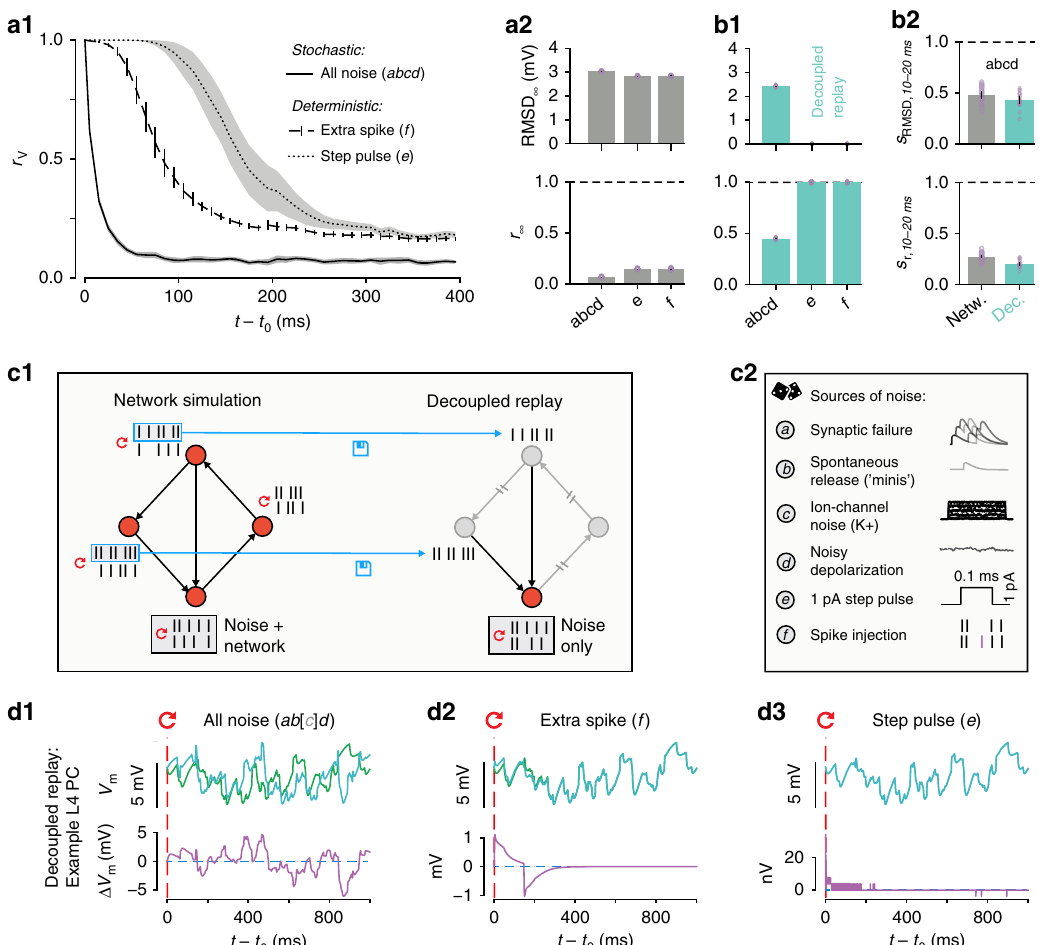
Fig. 3 Noise ampli fi ed by chaos determines divergence. a1 Time-course of correlation r V after resuming at t 0 from identical conditions with different forms of perturbation. Full cellular noise as before, solid line ( abcd ); no cellular noise, but perturbing with a single extra spike in one neuron, dashed line ( f ); a miniscule step-pulse perturbation in all neurons, dotted line ( e ). ( abcd : 40 saved base states; e , f : 20 saved base states; mean ± 95% con fi dence interval). a2 Steady-state root-mean square deviation RMSD ∞ and correlation r ∞ for stochastic ( abcd ) and deterministic simulations ( e , f ) as de fi ned in a1 (mean ± 95% con fi dence interval in black; individual base states in purple dots). b1 As in a2 , but for decoupled, replayed simulations. (20 saved base states). b2 Similarity s RMSD and s r at 10 – 20 ms with all noise sources enabled, for network and decoupled simulations (mean± 95% con fi dence interval). c1 Decoupled replay paradigm. Presynaptic spike trains from a network simulation are saved and then replayed to the synapses of each neuron in a decoupled simulation, thereby removing variability due to feedback network dynamics. c2 Overview of sources of noise and perturbations. d Decoupled replay simulations (see c1 ) for a representative L4 PC neuron, with somatic membrane potential differences between the two trials only due to cellular noise sources ( ab[c]d ), a stochastic ion channels are